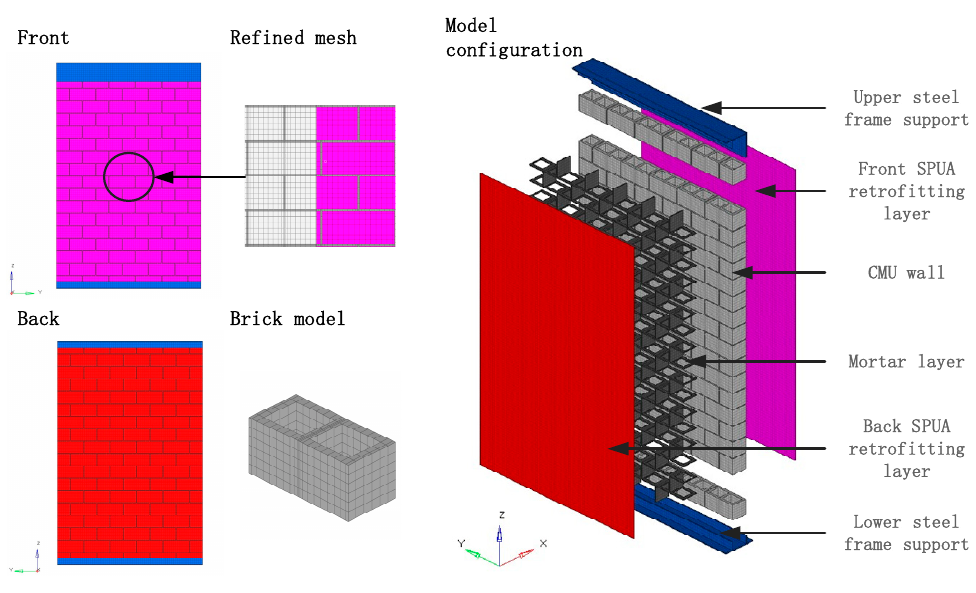
Figure 3. FE Model.